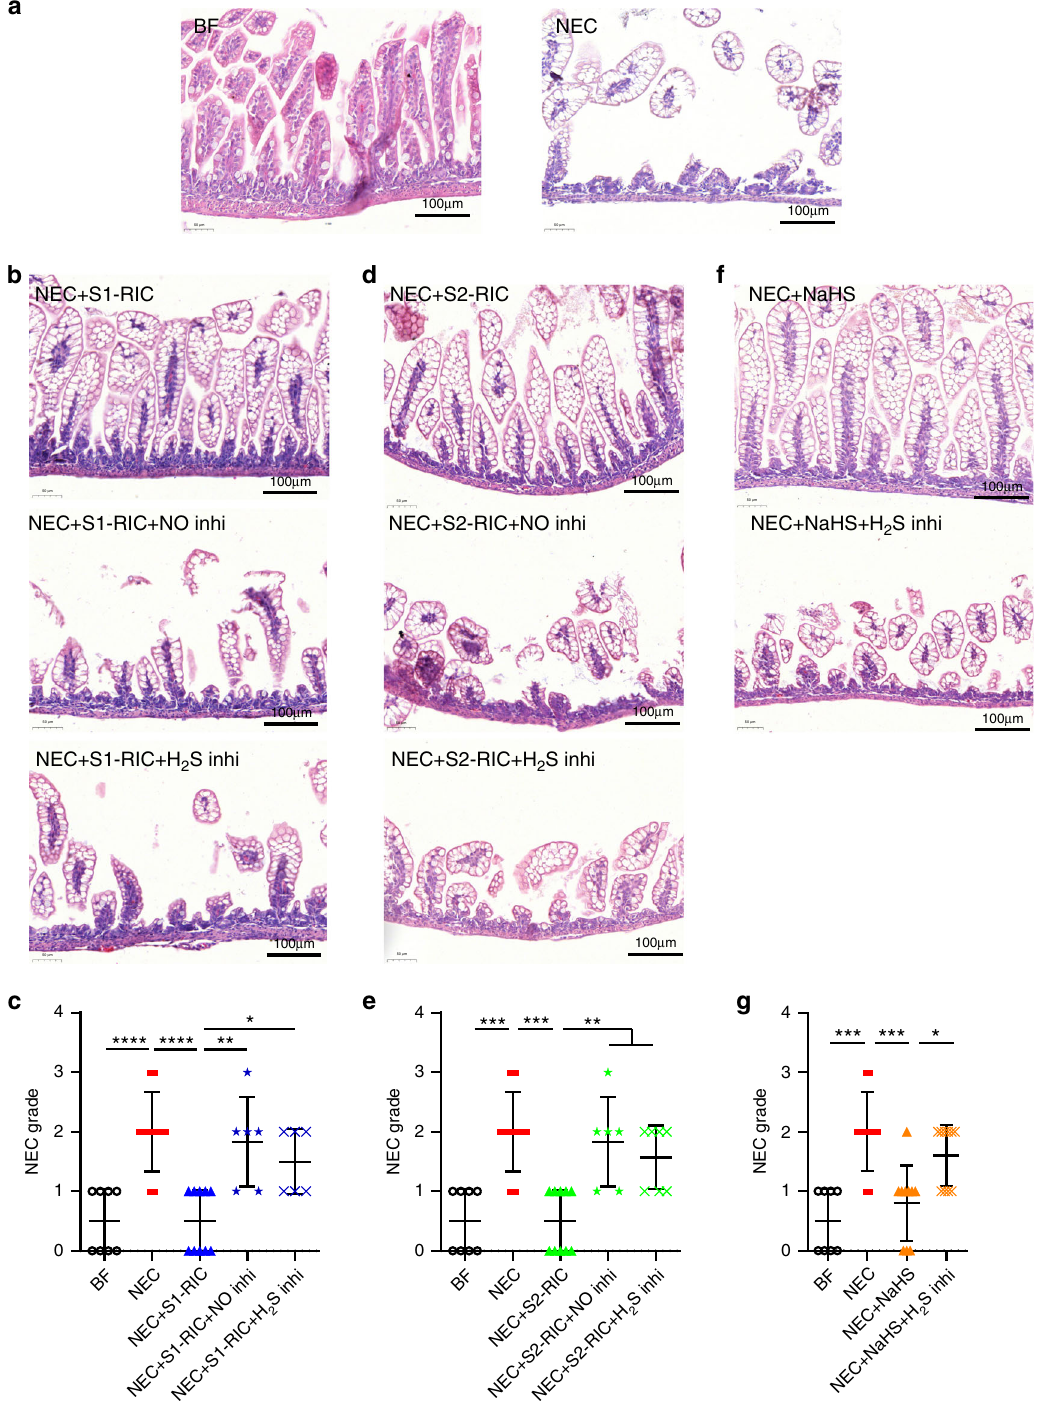
Fig. 7 RIC-mediated preservation of intestinal perfusion via nitric oxide and hydrogen sul fi de is required to improve intestinal injury during NEC. a Morphology of the ileum was assessed using hematoxylin and eosin staining in breastfed (BF) ( n = 8) control and NEC pups ( n = 10). Intestinal injury increased in NEC pups receiving b , c Stage 1 RIC following administration of inhibitors of NO-synthase ( n = 6) or H 2 S-synthesizing enzymes (n = 6), as well as in pups receiving d , e Stage 2 RIC following administration of inhibitors of NO-synthase (n = 6) or H 2 S-synthesizing enzymes ( n = 7) compared to NEC pups receiving Stage 1 RIC ( n = 10) or Stage 2 RIC ( n = 10) without drug treatment. Morphology of the ileum was assessed using hematoxylin and eosin staining and histological slides were graded by 3 investigators blinded to treatment allocation based on the NEC histopathological scoring system that de fi nes mice with NEC grade ≥ 2 as NEC positive. f , g Treatment with NaHS improved intestinal injury in NEC pups, resulting in a lower NEC grade, but not following treatment with H 2 S-synthesizing enzyme inhibitors (BF: n = 8; NEC: n = 10; NEC + NaHS: n = 10, NEC + NaHS + H2S-synthesizing enzyme inhibitors: n = 10). Data were compared using two-sided one-way ANOVA with post hoc Turkey test (* p < 0.05; ** p < 0.01; *** p < 0.001). Scale bars are equivalent to 100 µ m in a , b , d and f . Data are presented as mean ± SEM. Source data are provided as a Source Data fi